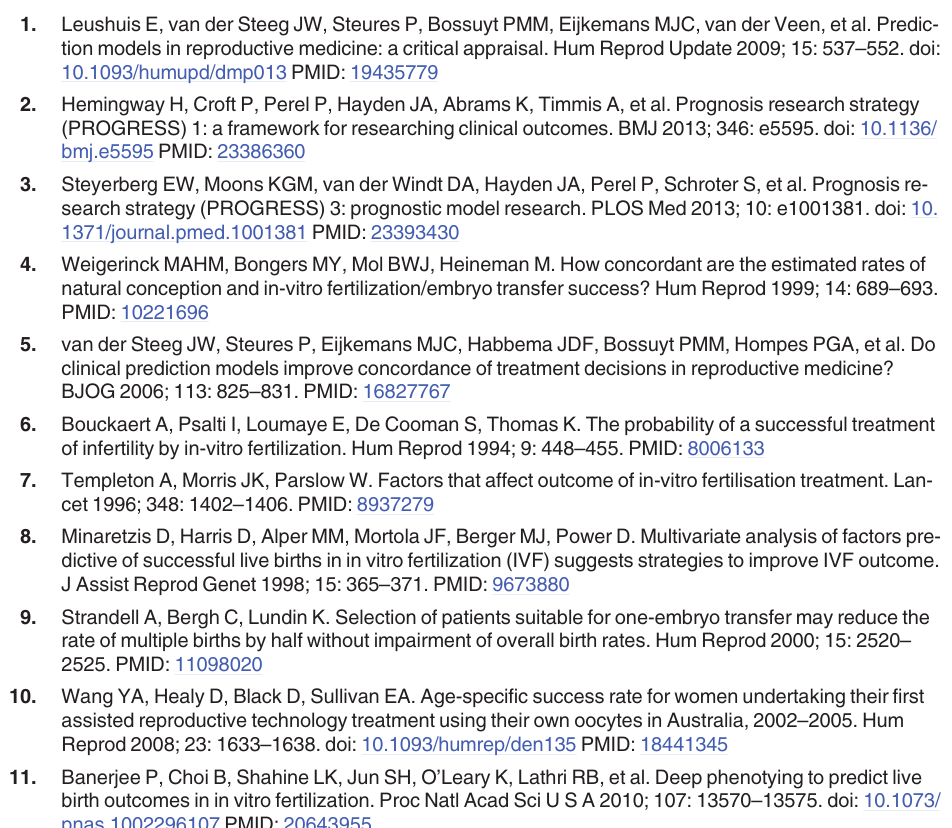
S3 Table. Observed and predicted live birth rates from the IVFpredict and Templeton mod- els. Stratified by characteristics of patients and treatment, in 130,960 IVF